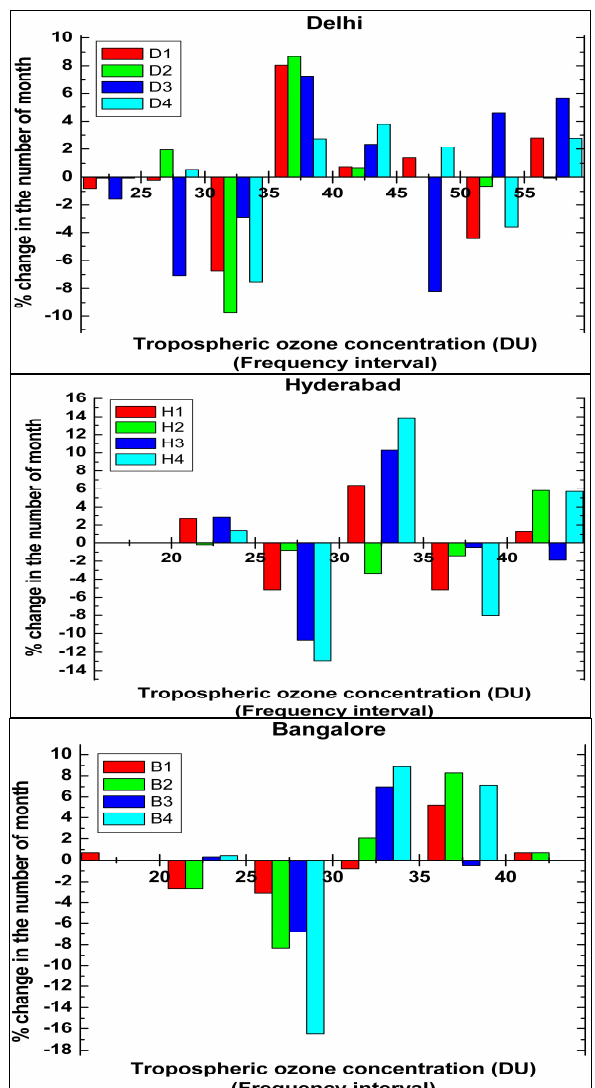
Fig. 2. Frequency distribution of % change in the number of months of tropospheric ozone concentration with frequency inter- val of 5DU in the concentration range from 20DU to 60DU over (a) Delhi and in the concentration range from 15DU to 60DU over (b) Hyderabad and (c)